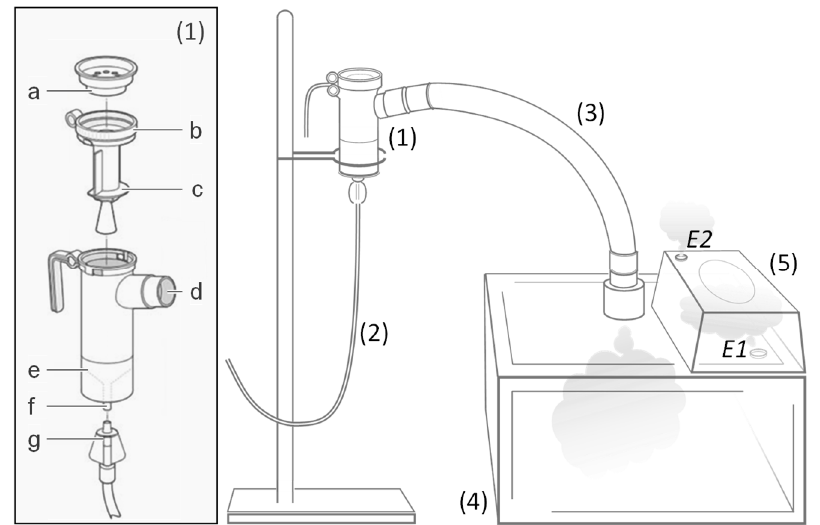
Figure 3. Aerosol experimental set-up. The illustration shows the clinically-validated PARI LC PLUS nebulizer (1) (comprising: a, inspiratory valve cap; b, insert; c, semi-circle; d, outlet; e, reservoir; f, air intake; g, wing tip tubing) connected on one side to a flexible hose (supplying two bars pressurized air) (2) and on the other side to a 55 cm tube (3) conducting the aerosol generated to a Perspex box (4) where mice were housed. Via an exit, E1, the aerosol reached a second compartment (5) fitted over the cover of the exposure box. This second compartment made it possible to expose other materials and to collect a sample of the aerosolized formulation. The aerosol finally left the system via an exit, E2. See Figure S1 for more details about the set-up. A video showing an aerosol experiment in mice is available from (“ Aerosol in mice.mp4 ”).